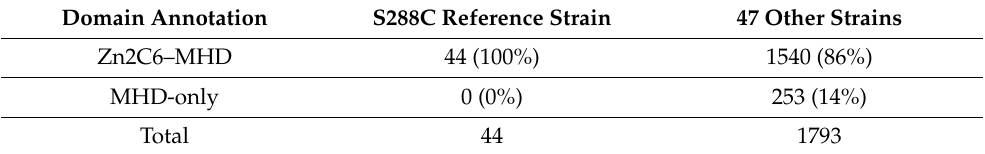
Table 1. Domain annotations of MHD-containing proteins in the SGD database. Domain Annotation